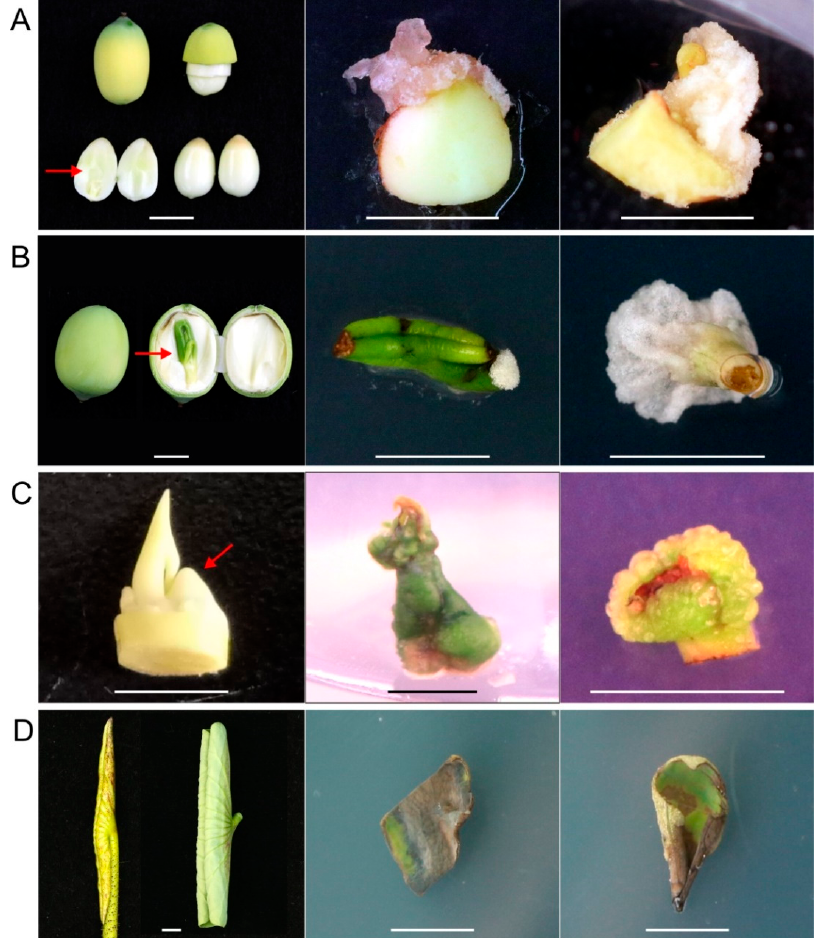
Figure 1. Callus induction in different lotus explants of the genotype “WBG_S1.” ( A ) Immature cotyledon explants from seeds at 9 days post pollination. ( B ) Immature embryo explants from seeds at 18 days post pollination. ( C ) Rhizome apical tip explants. ( D ) Leaf explants at the S3 and S4 developmental stages. Bars indicate the length of 1 cm. Red arrows indicate tissue/organ parts where explants were taken.